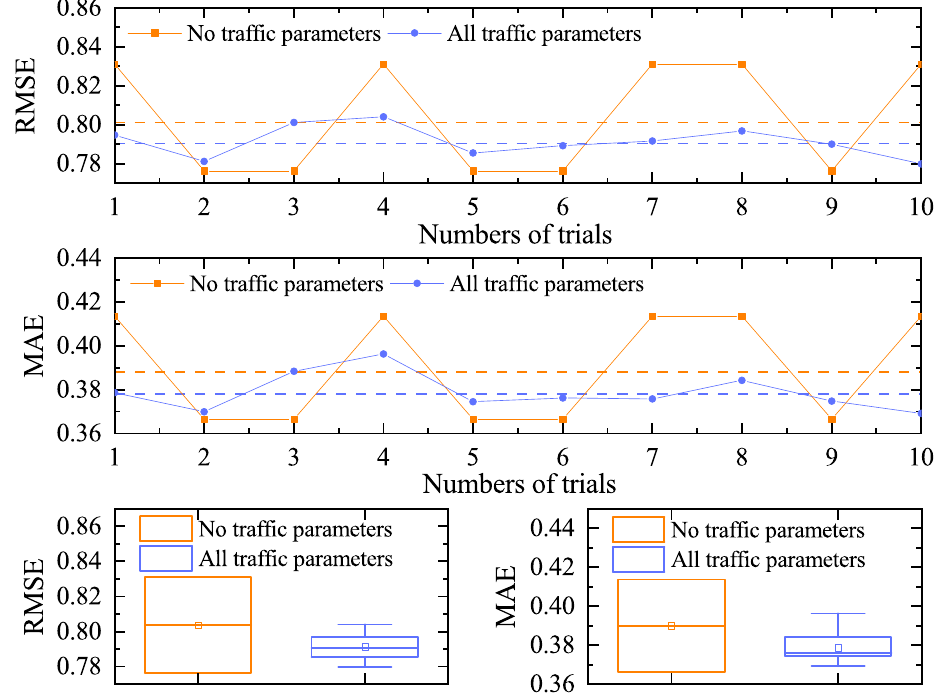
Figure 11. Performance of LSTM models with all traffic parameters and without traffic parameters. From the results, we observe that the LSTM model with all traffic parameters has presented better performance in predicting flight conflicts with error reduced by